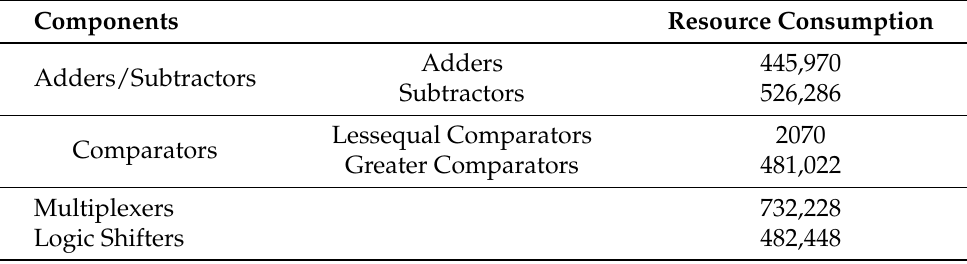
Table 1. Resource Breakdown of Multi-Size Circular-Shift Network for 5G NR LDPC